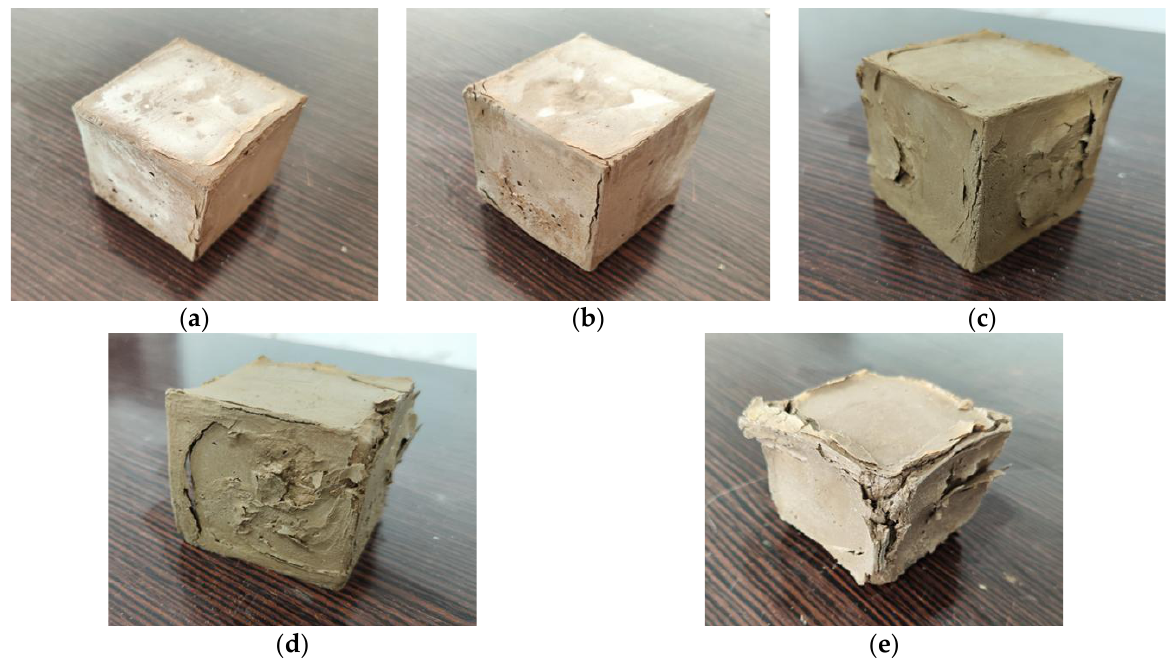
Figure 2. Appearance changes of cement-stabilized soil (C0 group) at different sulfate erosion ages: ( a ) 3 d; ( b ) 7 d; ( c ) 28 d; ( d ) 60 d; ( e ) 90 d.